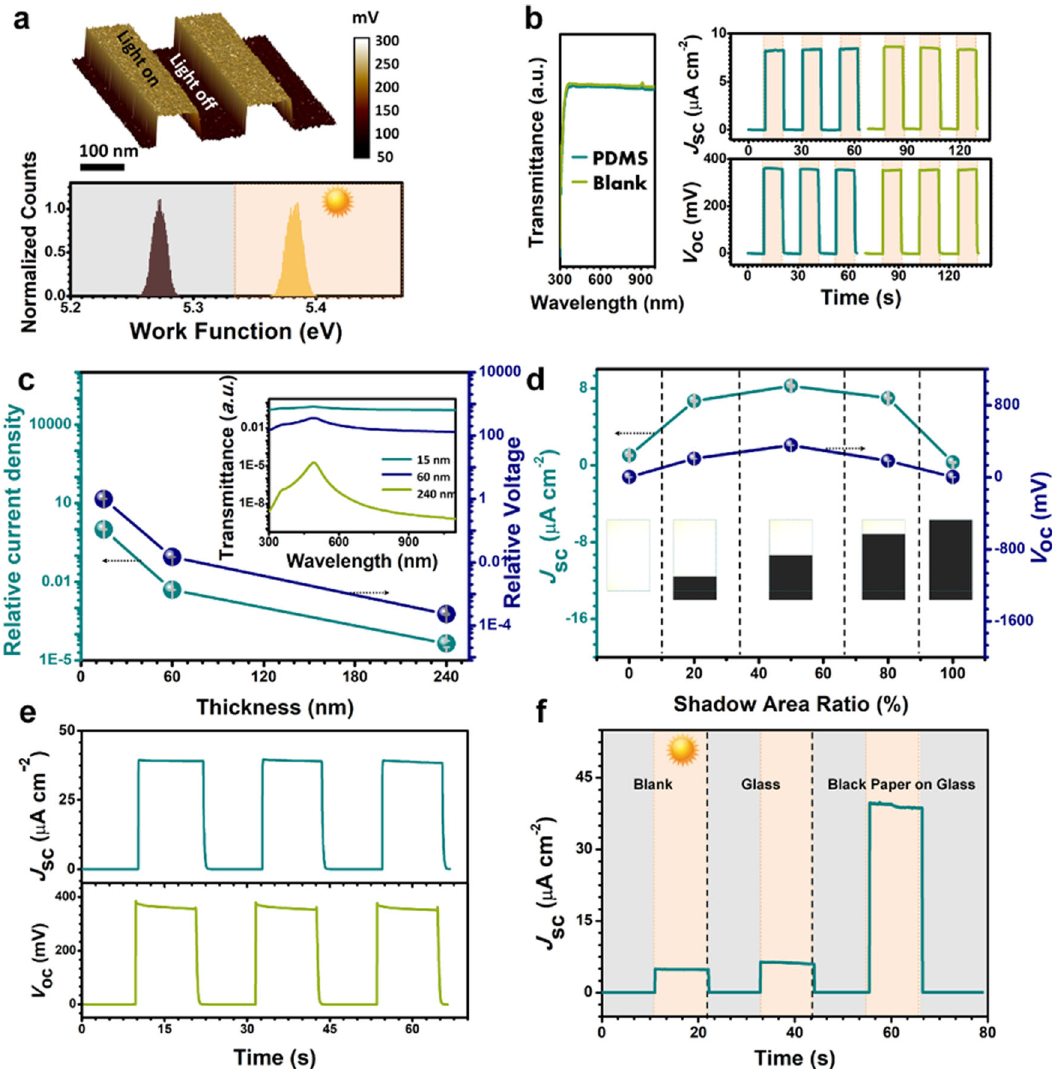
Fig. 2 Characteristics of the shadow-effect. a Surface potential map with two light on/light off cycles and work function shift of the dark and illumination (20 mWcm − 2 ). b UV-vis transmittance spectra, short-circuit current density ( J sc ) and open-circuit voltage ( V oc ) of the Au/n-Si system without (blank) and with PDMS fi lm. c The Relative current density ( J 15 /J 15 , J 60 /J 15 , J 240 /J 15 ) and relative voltage ( V 15 /V 15 , V 60 /V 15 , V 240 /V 15 ) versus the thickness of Au fi lm of the Au/n-Si system. Inset is transmittance of the Au fi lm with different thicknesses. d Effect of the ratio of shadow area on performance of Au/n-Si. e J sc and V oc of the Au/n-Si system after removing 1 cm Au fi lm in middle. f Performance of Au/n-Si system after removing middle Au fi lm half-shadowed by different shadow-casting objects (blank, glass, black paper on